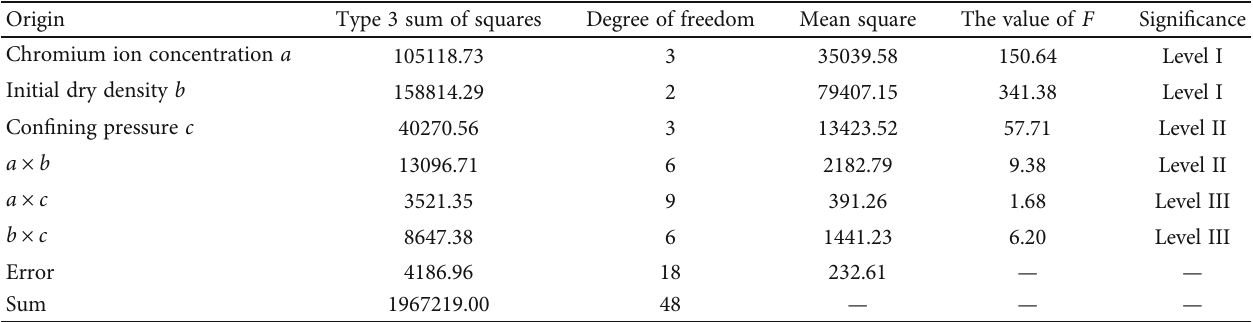
Table 6: Variance analysis table of the degree of in fl uence of each in fl uencing factor on the peak deviator stress (taking into account the interaction e ff